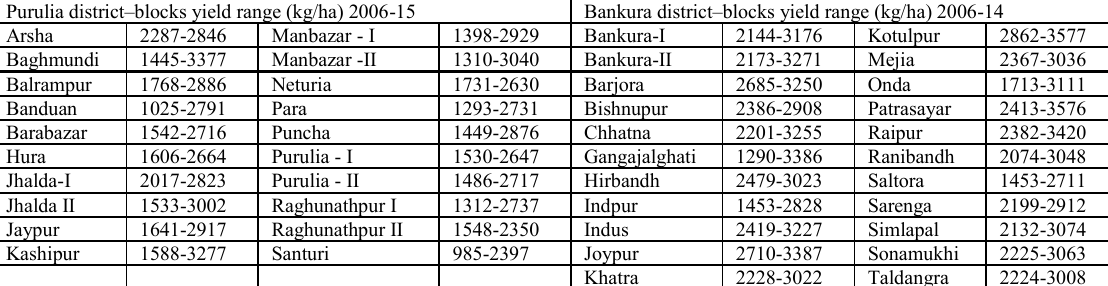
Table 2. Range of kharif rice yield variations during 2006-2015 in blocks of Purulia & Bankura districts